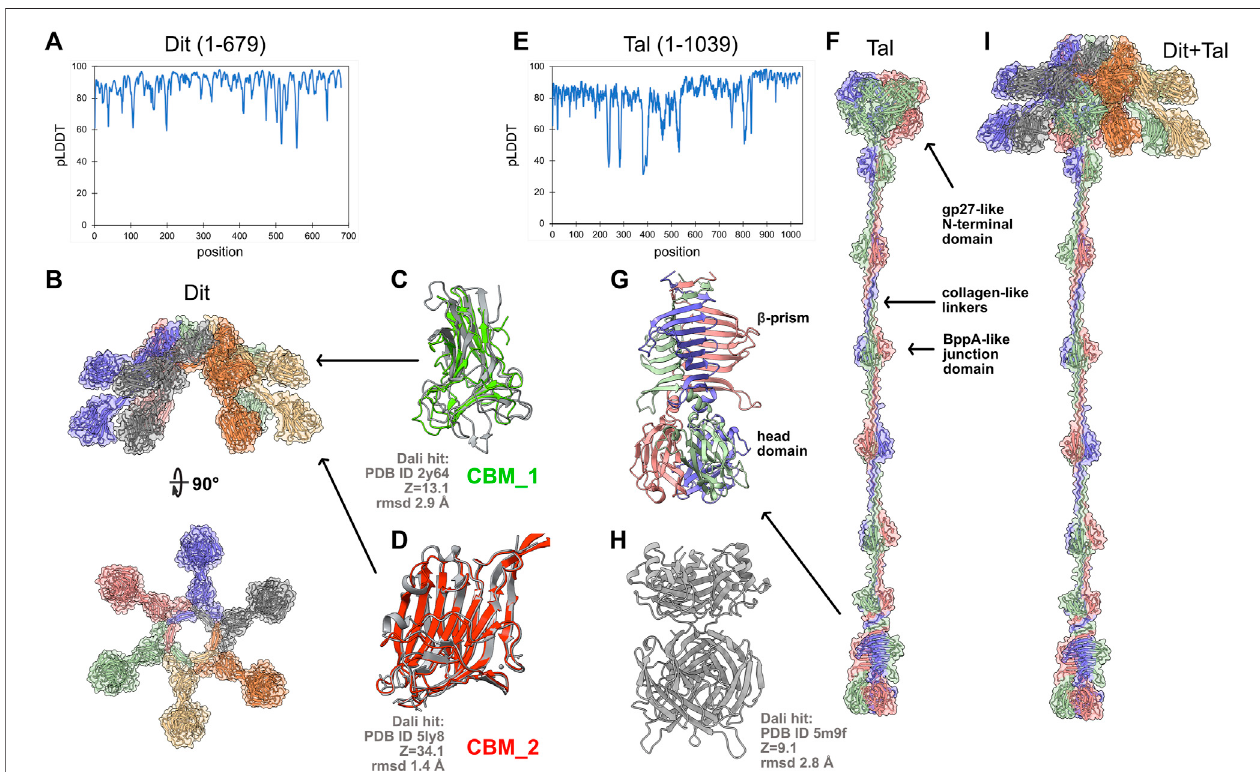
FIGURE2| StructurepredictionofthehostadhesiondevicefromL.caseiphageJ-1. (A) pLDDTplotforthefull-lengthDitpredictedstructure. (B) Orthogonalviews of the Dit hexamer. In the surface and ribbon representations, each monomer is differently colored. (C) Superposition of the Dit CBM_1 onto the CBM4-2 from a thermostable Rhodothermus marinus xylanase returned as a signi fi cant hit using Dali. (D) Superposition of the Dit CBM_2 predicted and crystal structures. (E) pLDDT plot for the full-length Tal predicted structure. (F) Surface and ribbon representations of the Tal trimeric assembly (each monomer is differently colored). (G) Close- up view on Tal C-terminal domain, the likely J-1 ’ s RBP. (H) The Tal C-terminal domain returned the Staphylococcus Virus K RBP as signi fi cant hit using the Dali server (Dali statistics apply to the head domain). (I) Surface and ribbon representations of the entire J-1 adhesion device. Figures were generated with ChimeraX (Pettersen et al.,